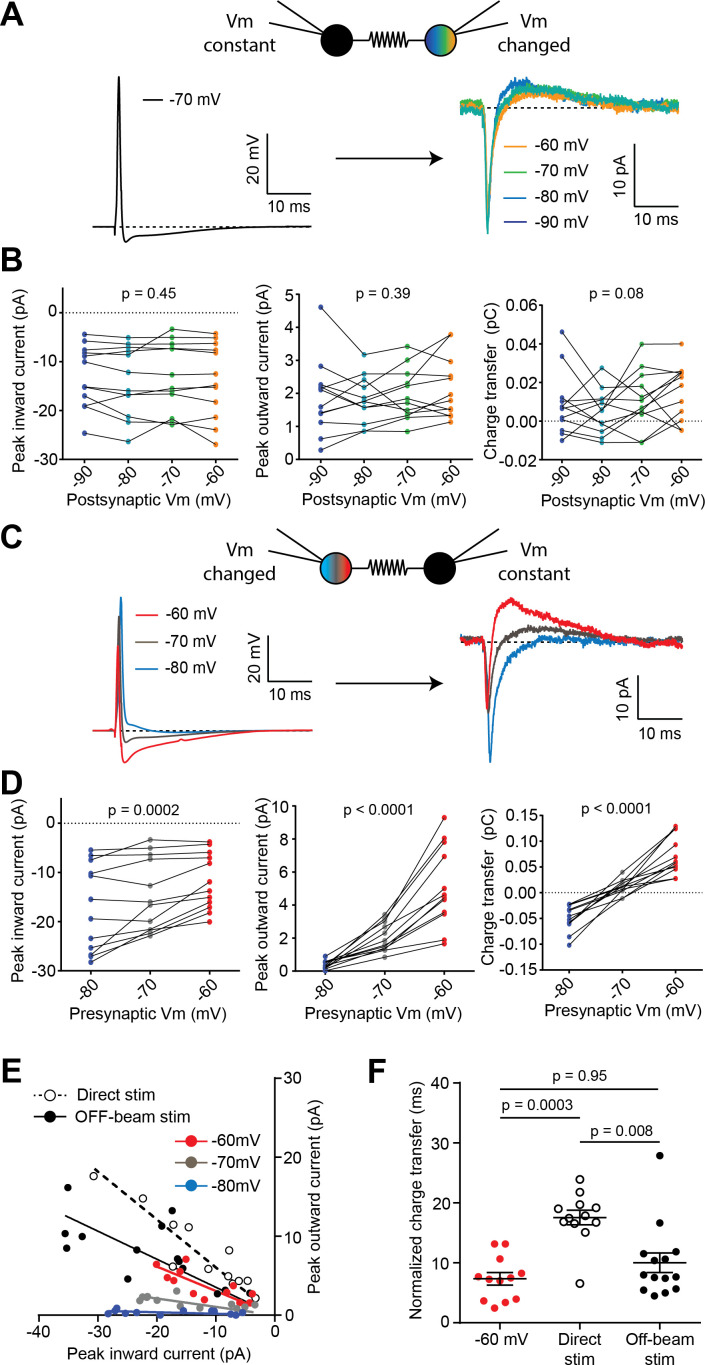
Presynaptic resting potential influences polarity of spikelets.(A) Action potential from one cell of a paired BC recording (left; holding potential = −70 mV) and corresponding spikelets current recorded in a voltage-clamped postsynaptic cell at different holding membrane potentials (Vm, right). (B) Inward current peak amplitude (left panel), outward current peak amplitude (middle panel) and charge transfer (right panel) are not significantly altered by changing postsynaptic Vm (n = 12 spikelets from 6 BC pairs, three independent Friedman tests, p-values from left to right: p=0.45, p=0.39, p=0.08). (C) Action potential waveforms from the same cell recorded at three different resting Vm (left), with corresponding spikelets recorded in the postsynaptic cell, held at −70 mV in voltage-clamp (right). (D) Inward current peak amplitude (left panel), outward current peak amplitude (middle panel) and charge transfer (right panel) are all significantly altered by changing the resting membrane potential of the presynaptic cell (n = 12 spikelets from six pairs, three independent Friedman tests). (E) Plot of outward versus inward current peak amplitudes of spikelets recorded under five conditions: either from pairs of connected BCs (Presynaptic Vm = −60,–70, −80 mV), from extracellular direct stimulation (dotted) or off-beam stimulation (black). Regression lines were performed on the individual groups. Slopes were significantly different between the −60, –70, and −80 mV groups (F-test, p-value=0.0003), significantly different between the direct stimulation and the −60 mV groups (p-value=0.013), but not different between the off-beam stimulation and −60 mV groups (p-value=0.93). (F) Summary plot of peak-normalized inward charge transfer of spikelets recorded in voltage clamp and elicited from a transmitting BC pair whose holding potential (Vm) was −60 mV, or from extracellular direct and off-beam stimulation (Kruskal-Wallis test with Dunn’s multiple comparisons; −60 mV (Pair): n = 12 cells from six pairs, Direct stim.: n = 12 stimulation sites over 10 cells, off-beam stim.: n = 14 sites over 11 cells). See also Figure 5—source data 1.Figure 5—source data 1.Presynaptic resting potential influences polarity of spikelets.